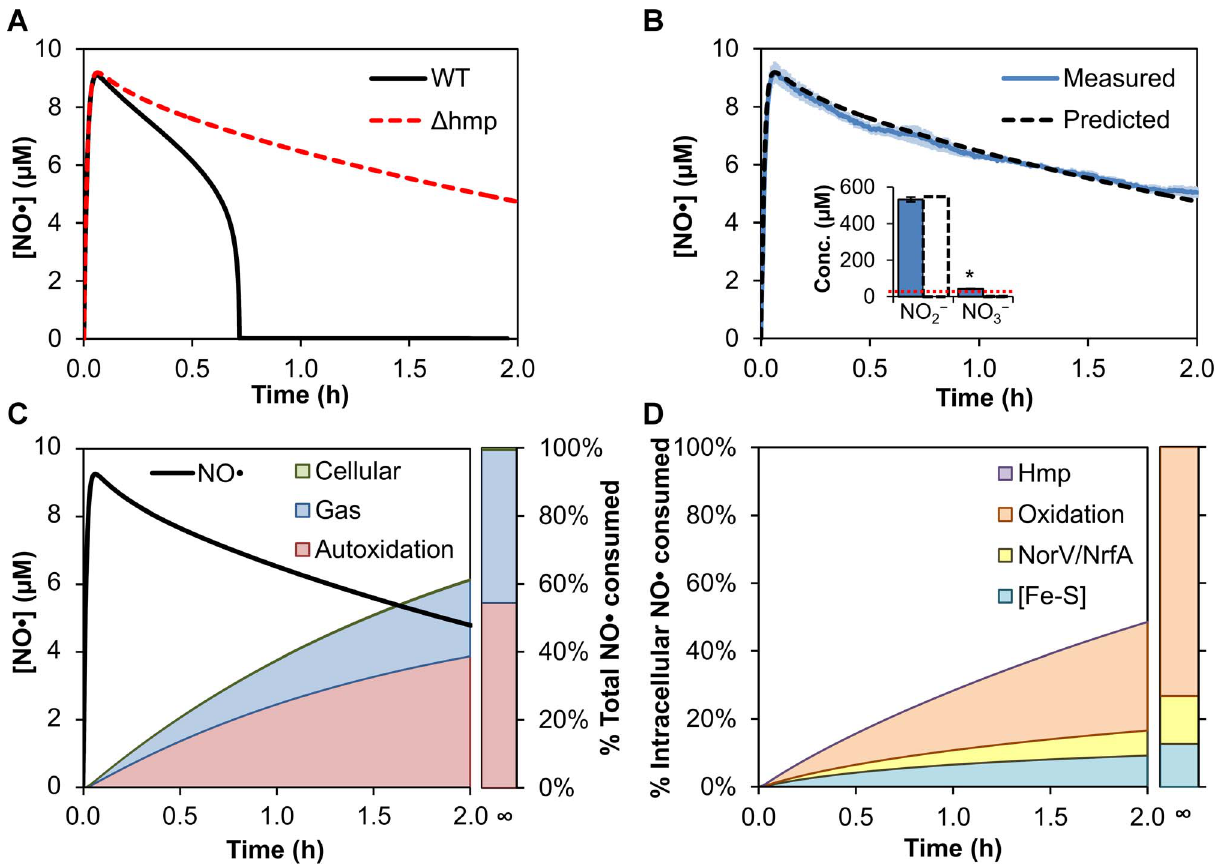
Figure 3. Effect of D hmp on NO N dynamics in aerobic E.coli cultures. (A) Simulated NO N profiles for wild-type (solid black line) and D hmp (dashed red line) cultures following addition of 0.5 mM DPTA. (B) NO N concentration following delivery of 0.5 mM DPTA NONOate to a culture of exponential-phase, D hmp E. coli at an OD 600 of 0.05 was measured experimentally (solid blue line) and predicted by the model (dashed black line). Error bars (light blue) represent the standard error of the mean for 3 independent experiments. The inset shows the measured (blue bars) and predicted (dashed white bars) NO 2 2 and NO 3 2 concentrations at 10 h after DPTA delivery to the D hmp culture. Error bars represent the standard error of the mean for 3 independent experiments. The dotted red line represents the limit of detection for the assay, with the asterisk (*) indicating that the measured [NO 3 2 ] was negligible, as it did not differ significantly from the detection limit (one-sample t -test, 95% confidence). (C) Simulated NO N concentration profile (black line) and corresponding cumulative distribution of total NO N consumption following addition of 0.5 mM DPTA to D hmp E. coli . (D) Predicted cumulative distribution of intracellular NO N consumption in a D hmp culture following addition of 0.5 mM DPTA.